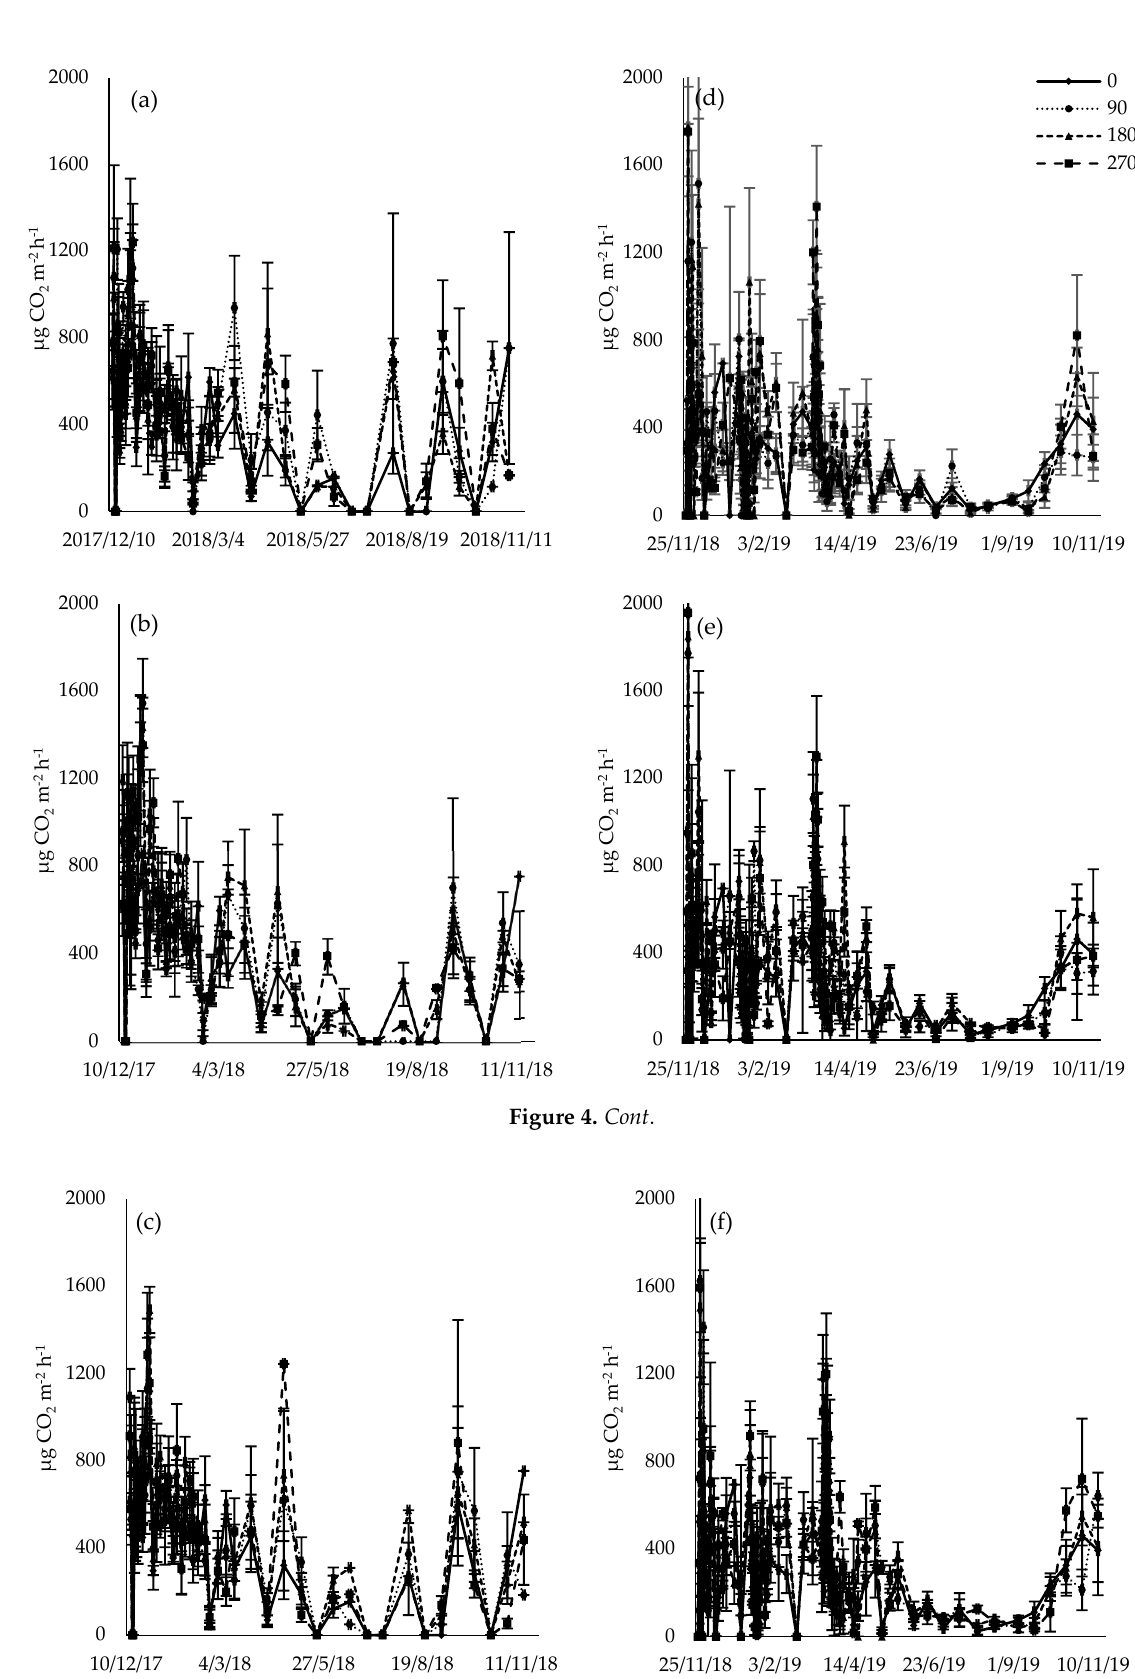
Figure 4. Descriptive average of CO 2 fluxes (mg m − 2 h − 1 ) of pastures fertilized with N fertilizers in two experiments: exper- iment 1: ( a ) urea, ( b ) ammonium nitrate, ( c ) ammonium sulfate; experiment 2: ( d ) urea, ( e ) ammonium nitrate, ( f ) ammo- nium sulfate.